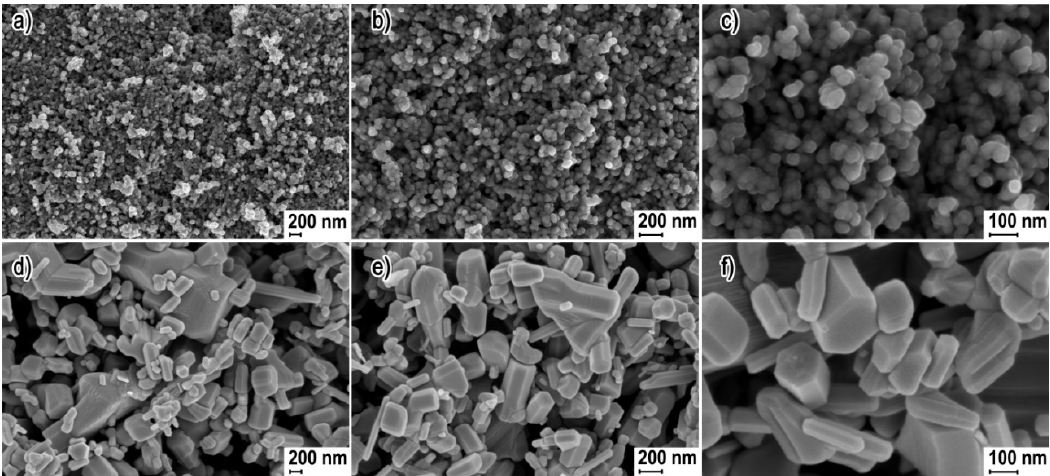
Figure 1. Scanning electron microscopy (SEM) images of zinc oxide nanoparticles (ZnO NPs) ( a,b,c ) and Zinc oxide submicron particles (ZnO SMPs) ( d,e,f ) .